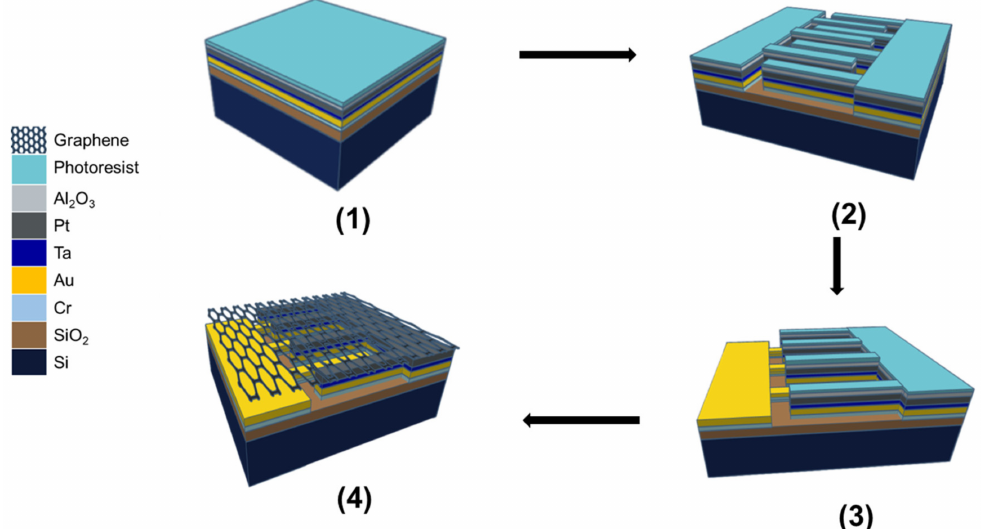
Figure 1. The fabrication steps of the graphene photodetector interdigitated electrodes device: ( 1 ) deposition of all the metals and the photoresist; ( 2 ) lithography and ion milling; ( 3 ) second lithography and ion milling of Pt metal; ( 4 ) graphene